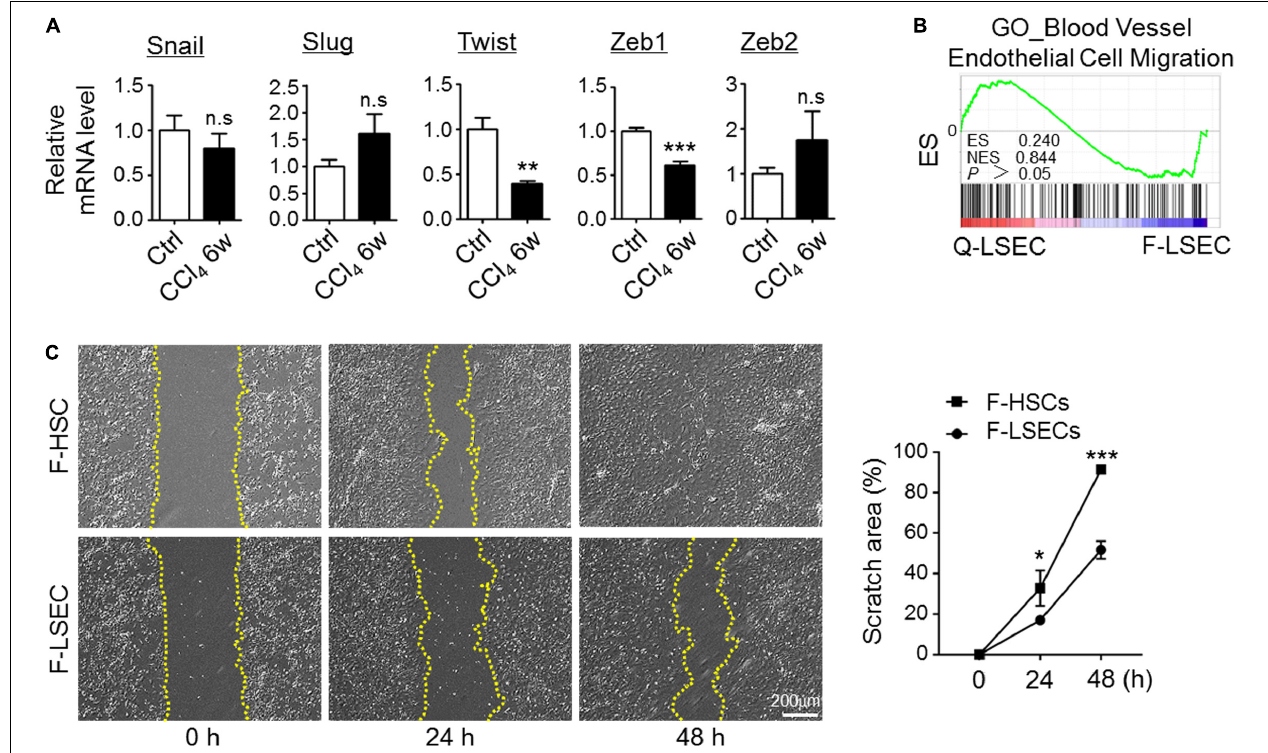
FIGURE 3 | Mesenchymal transition of LSECs is partial in fibrosis. (A) LSECs were isolated from control and fibrotic mice, and the expression of EndMT-related transcription factors was determined by qRT-PCR ( n = 3–4). Bars = means ± SD; ** P < 0.01, *** P < 0.001 vs. control LSECs, using two-tailed t -test. (B) Genes reflecting vascular endothelial cell migration were compared between Q-LSEC and F-LSEC with GSEA ( n = 3). (C) LSECs and HSCs were isolated from the fibrotic mice (F-LSEC and F-HSC, respectively), and cell migration was determined by scratch assay ( n = 4). Bars = means ± SD; * P < 0.05, *** P < 0.001 vs. fibrotic-LSECs, using two-tailed t -test; n.s., not significant. Q-LSEC, quiescent LSEC; F-LSEC, fibrotic LSEC; F-HSC, fibrotic HSCs; GSEA, gene set enrichment